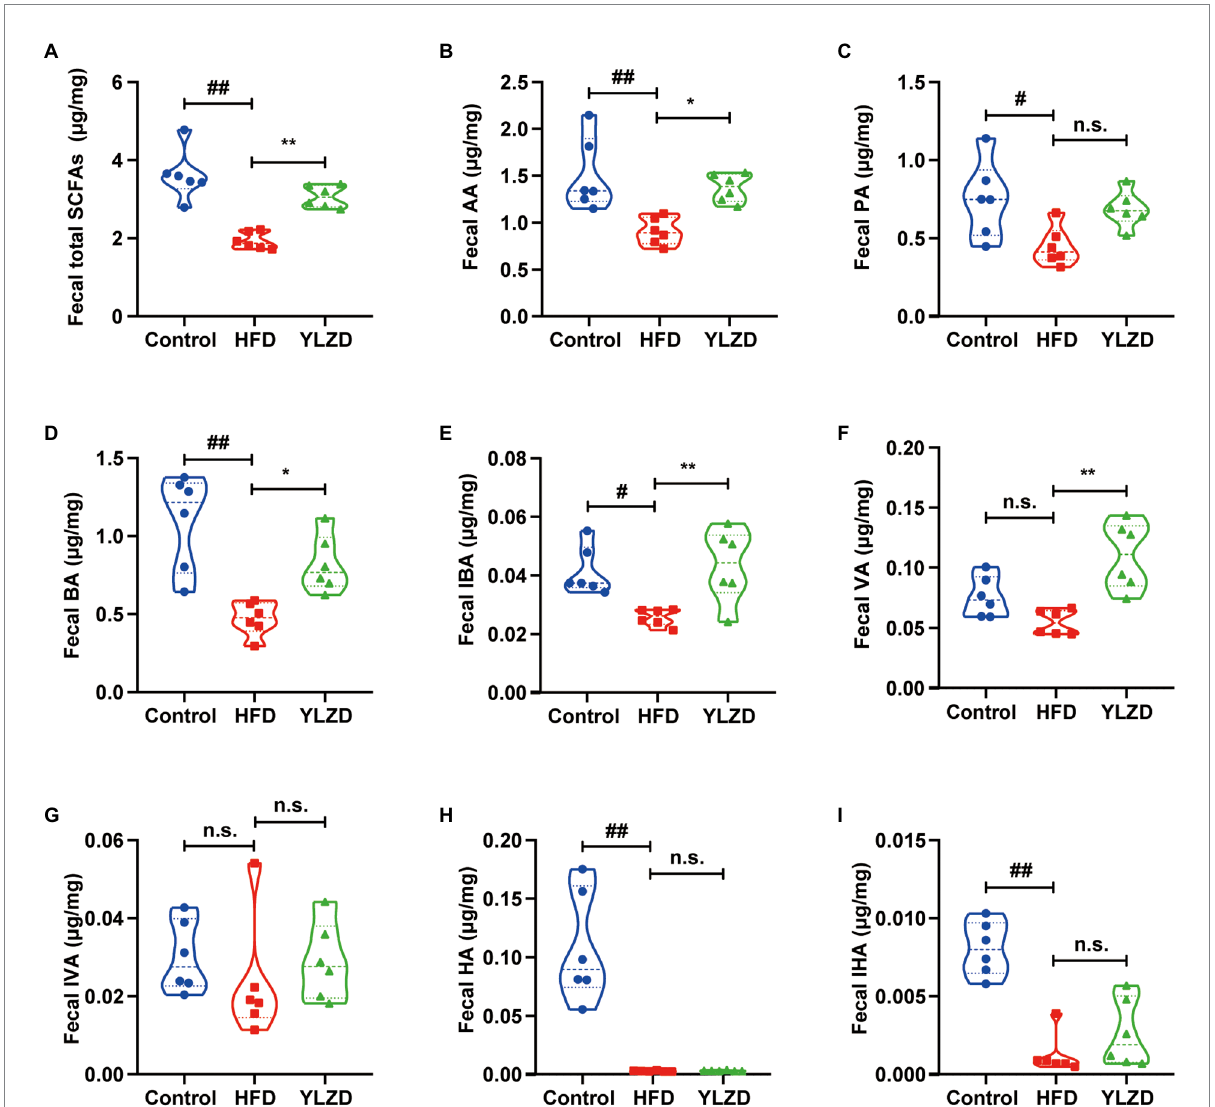
FIGURE 5 YLZD raised the concentration of fecal SCFAs. (A) Fecal total SCFAs, (B) fecal AA, (C) fecal PA, (D) fecal BA, (E) fecal IBA, (F) fecal VA, (G) fecal IVA, (H) fecal HA, (I) fecal IHA. Values are represented as mean ± SEM ( n = 6 rats/group). ## p < 0.01, # p < 0.05 versus the Control group; ** p < 0.01, * p < 0.05 versus the HFD